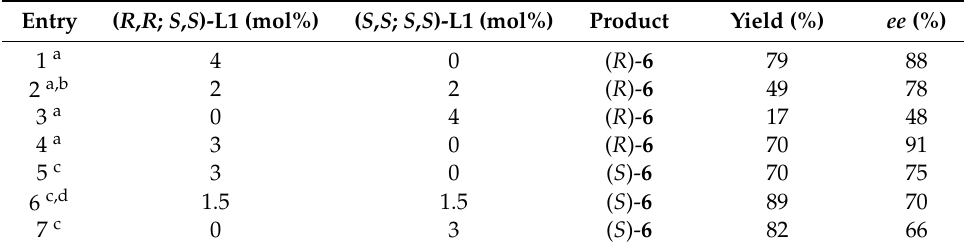
Table 8. E ff ect of chiral azolium ligand L1 in the conjugate addition reaction of 5